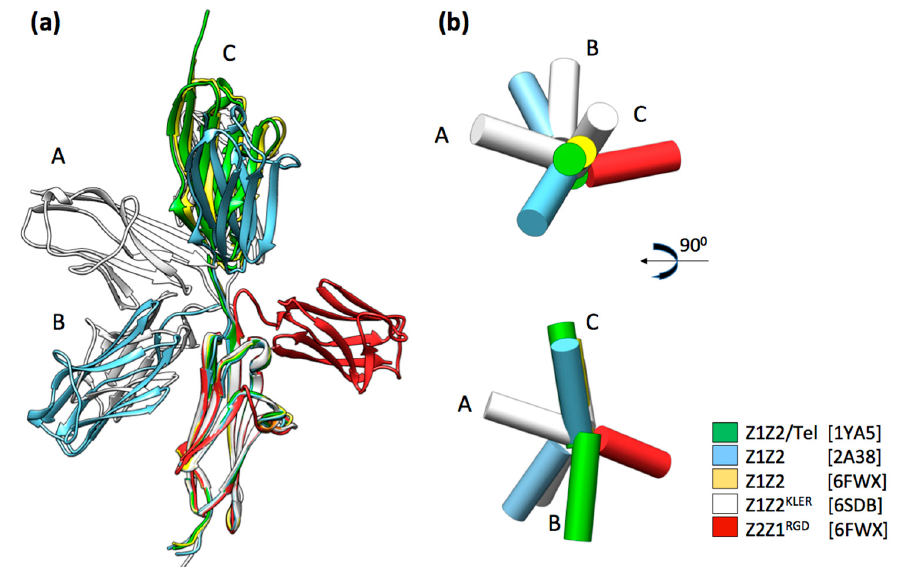
Figure 2. Conformational dynamics in the natural linker sequence of Z1Z2 from titin. ( a ) Conformations of the Z1Z2 Ig-doublets observed experimentally in crystal structures. All pairs are superimposed onto Z1 with the exception of the engineered Z2Z1 pair, where its Z2 domain is superimposed onto Z1 in the other pairs as to allow for comparison. The natural KAET linker sequence that connects Z1 with Z2 is flexible and permits inter-domain motions of large amplitude. In the Z1Z2/Tel pair, the Z1Z2 molecule displayed has been extracted from the structure of the complex illustrated in Figure 1a. The structure of Z1Z2 in isolation (blue) was observed in two conformations: Extended and a tight V-shape. The structure of Z1Z2 carrying the KLER motif in the CD-loop (white) was observed in three inter-domain conformations, here labeled A, B, and C to ease identification. The structure of the Z2–Z1 pair (red) shows that the flexibility of the KAET sequence is reproduced by the engineered linker sequence; ( b ) schematic representation of the domain arrangements shown in (a) where Ig domains are displayed as cylinders (lateral and top views are provided).